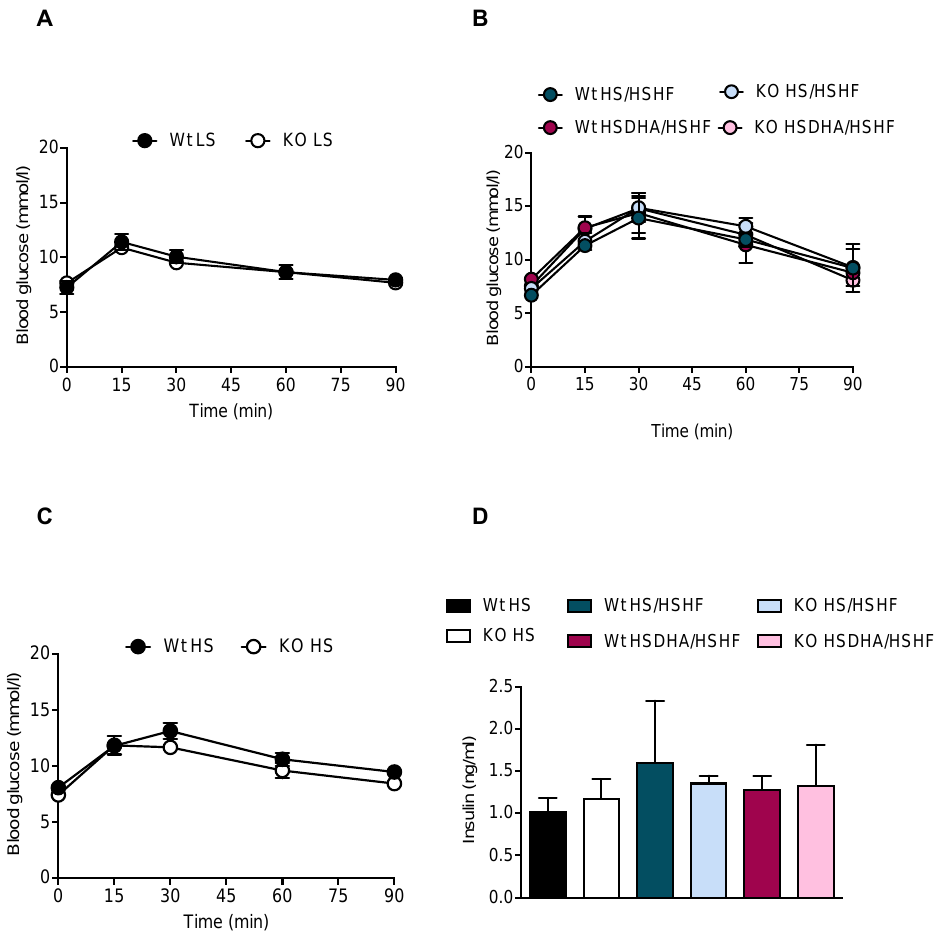
Figure 6. Glucose tolerance of Elovl2 - / - mice is not a ff ected by high dietary sucrose content and DHA supplementation. ( A ) Glucose tolerance test performed on wild-type and Elovl2 - / - mice fed standard chow diet at the start point of experiment. ( B ) Glucose tolerance test after six weeks of dietary treatment (four weeks of high-sucrose diet (HS) or high-sucrose DHA-enriched diet (HSDHA) followed by two weeks of high-sucrose, high-fat (HSHF)). ( C ) Glucose tolerance test performed on wild-type and Elovl2 - / - mice fed high-sucrose diet for eight weeks. ( D ) Insulin levels after GTT of the groups shown in ( B , C ). Results shown are means of four mice ± SEM.